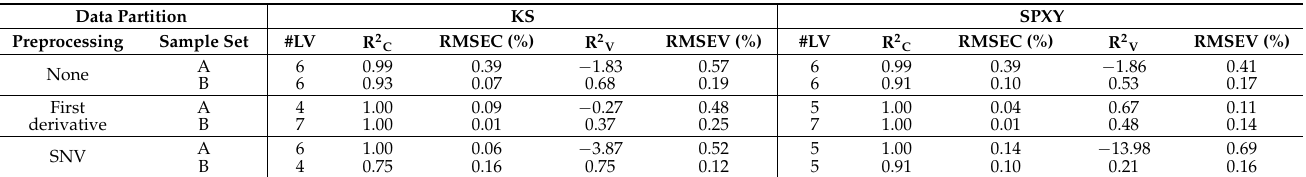
Table 3. Validation performance of global protein models (set A) and local protein models (set